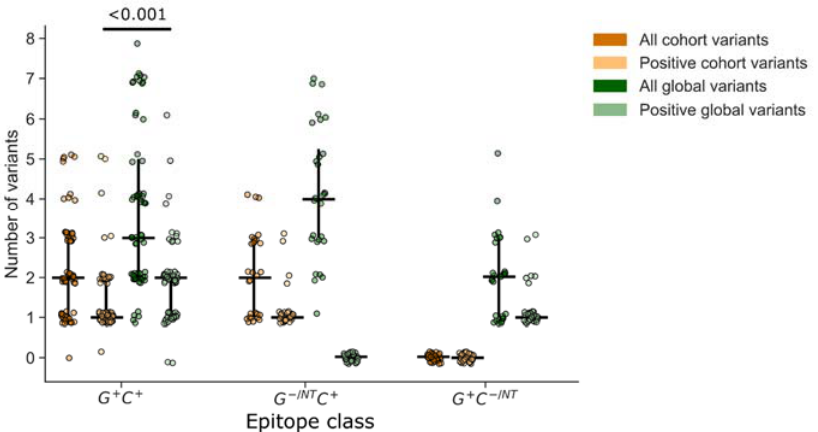
Figure 6. T cell response depth. Response depth was estimated by counting the number of peptides with unique sequence variations within the putative epitope region. For each peptide set, global vs. cohort, we counted the total number of unique peptide variants and the number that were contained within at least one peptide that tested positive. Each symbol represents one epitope, recognized by one participant (n = 118 epitopes). Vertical lines indicate the IQR with horizontal lines indicating the median. Epitopes are categorized based on their identification by at least one positive peptide from each set (G + C + ), or from one set and not the other (G − /NT C + or G + C − /NT ).